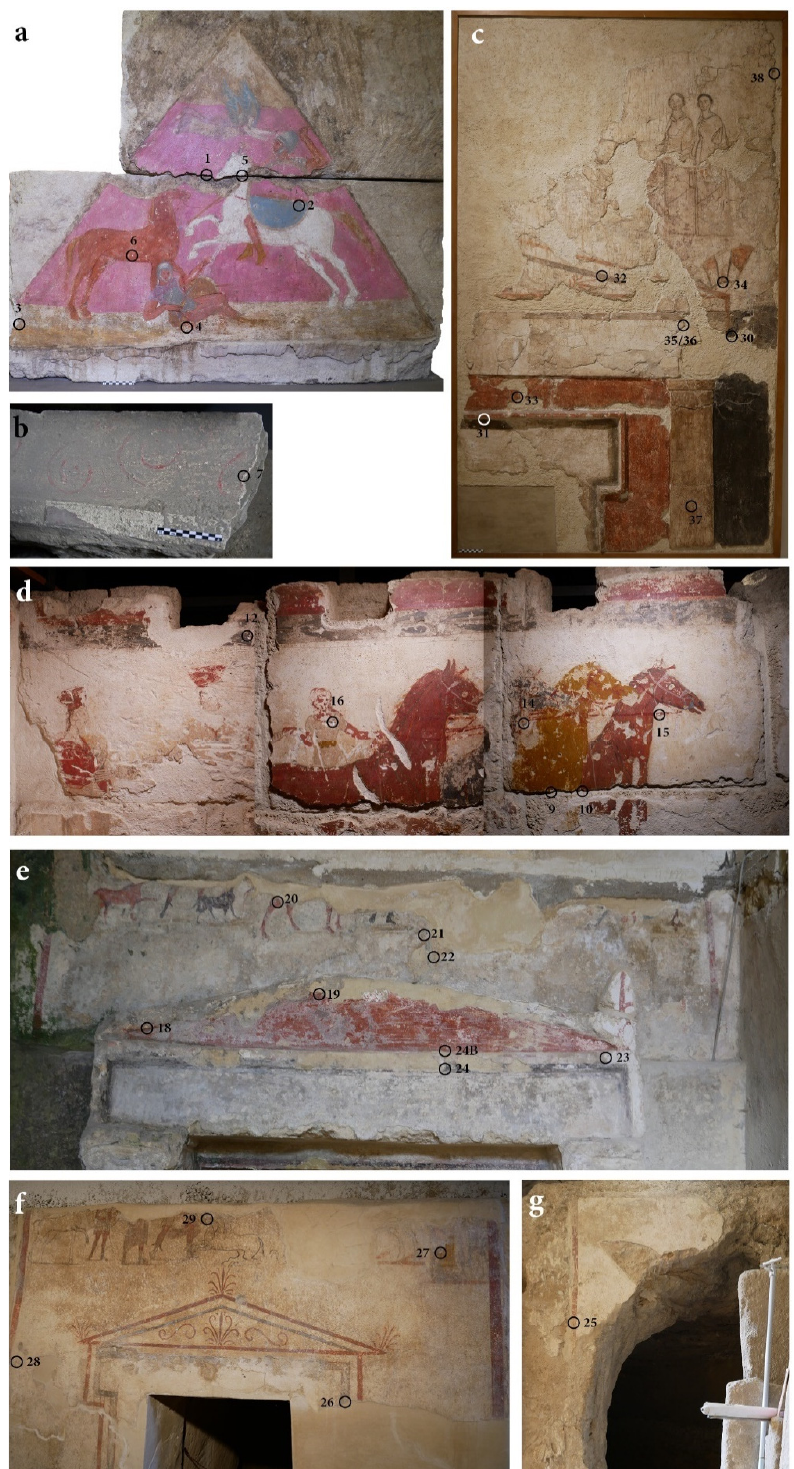
Figure 11. Sampling areas: Tomba della Nike pediment ( a ), wall band with spirals ( b ); Ipogeo Sant’Aloia ( c ); Tomba dei Cavalieri ( d ); Ipogeo Scocchera B ( e ); Ipogeo del Cerbero ( f – g ). Images used by permission of Soprintendenza Archeologia, Belle Arti e Paesaggio per le Province di BAT e FG ( a , b , d – g ) and Direzione Regionale Musei Puglia-Ministero della Cultura ( c ).